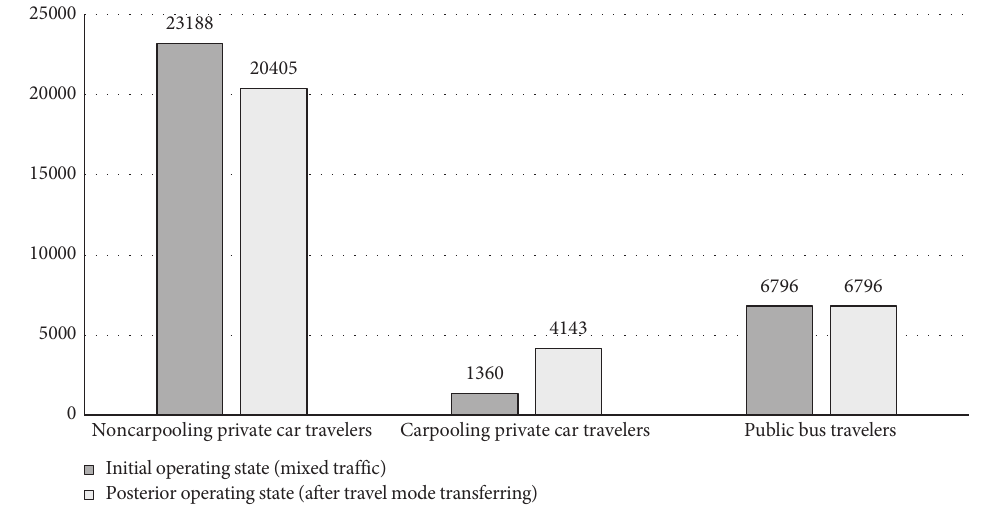
Figure 8: Comparison of number of travelers before and after implementing HOV lanes priority dynamic control for different travel modes.